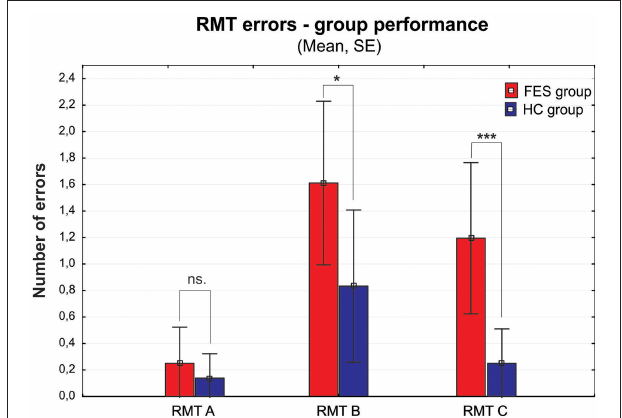
FIGURE 2 | Group performance presented as number of errors on the Money Road Map Test (RMT) (mean ± standard error). Errors are divided into three different types according to the rotation toward subjective perspective of the tested subject (A–less than 70 ◦ deviation from subject’s heading; B–90 ◦ ; C–more than 110 ◦ ). FES group, first psychotic episodes of schizophrenia spectrum disorders; HC group, healthy controls. Significance; ns, non-significant; * p < 0.05 , *** p < 0.001